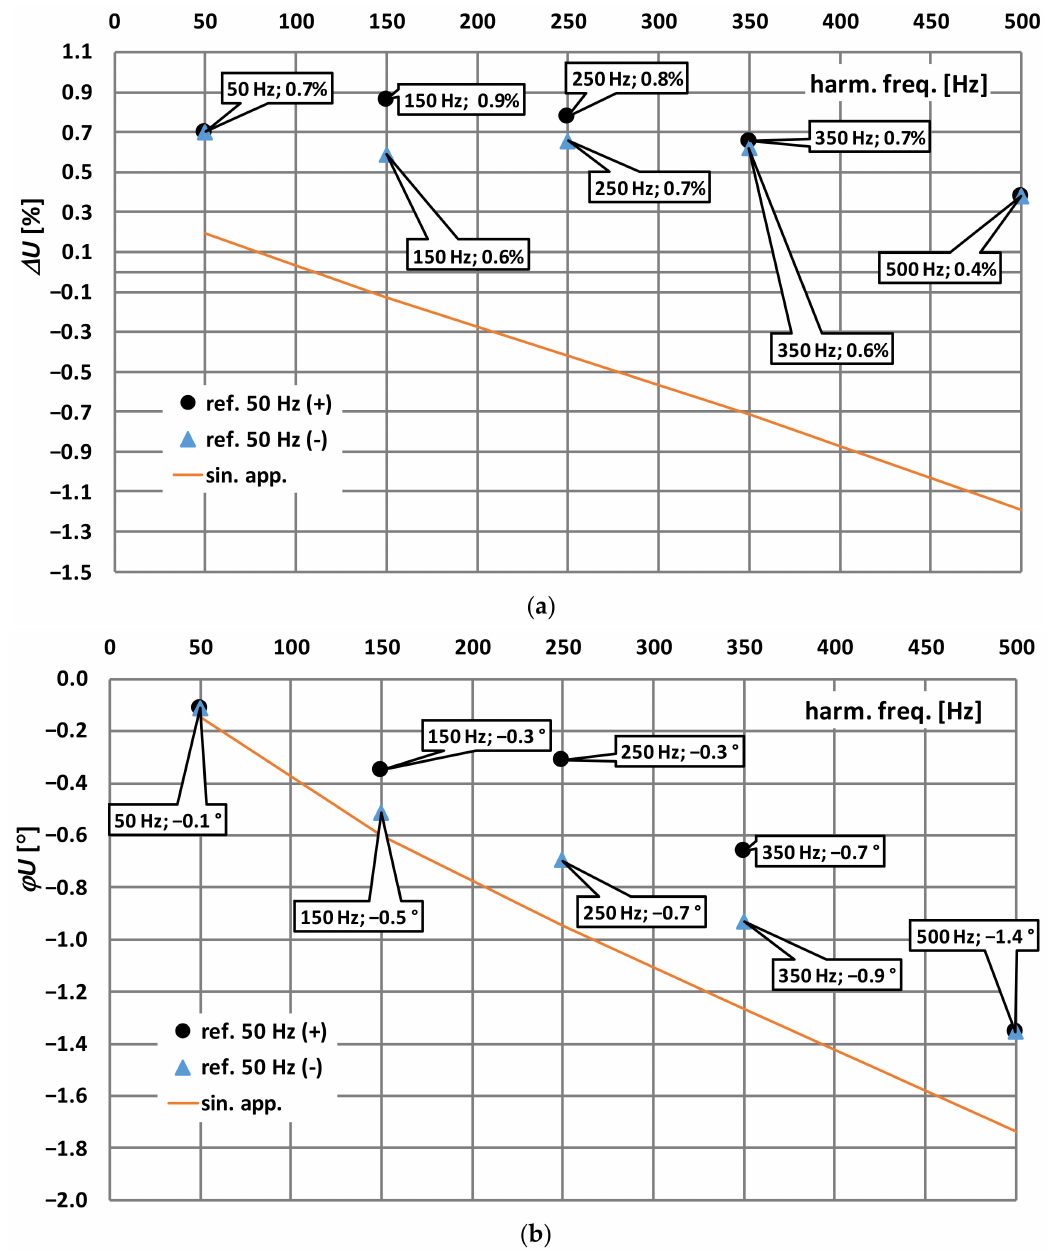
√ 3) kV VT for harmonics of the non-sinusoidal